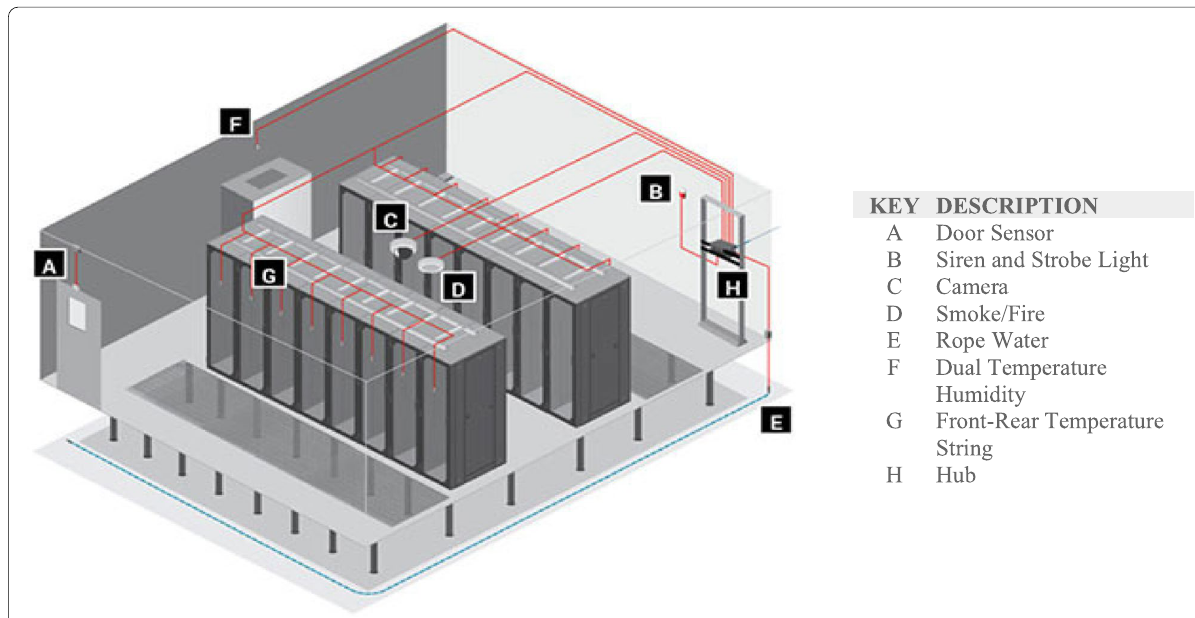
Fig. 7 Example of modern datacentre server room with environmental monitoring system